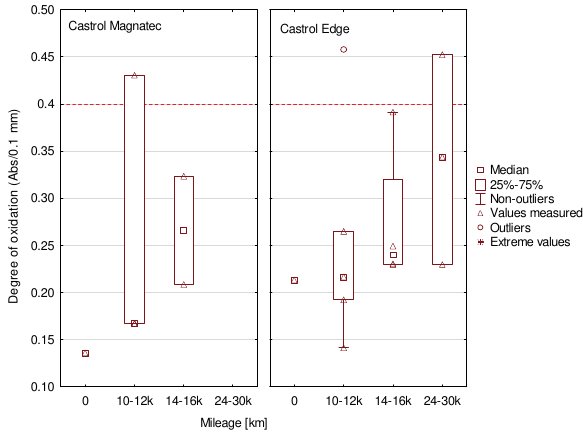
Fig. 5. The degree of oxidation of the engine oils tested